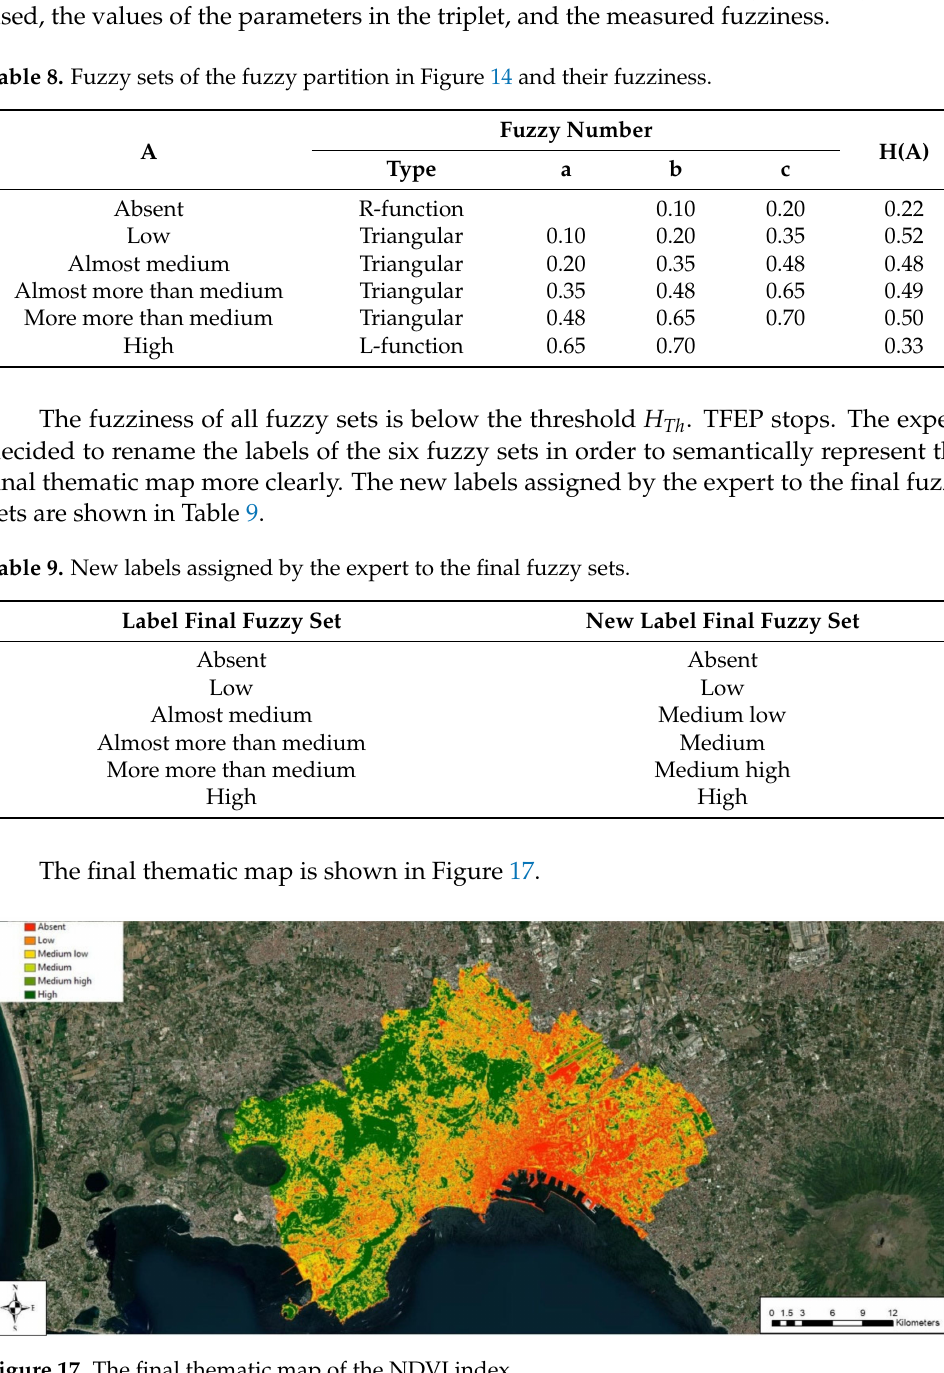
Figure 17. The final thematic map of the NDVI index. The fuzziness H ( F ) of the fuzzy partition, computed by (7) is 0.42; then, the reliability of the final thematic map is